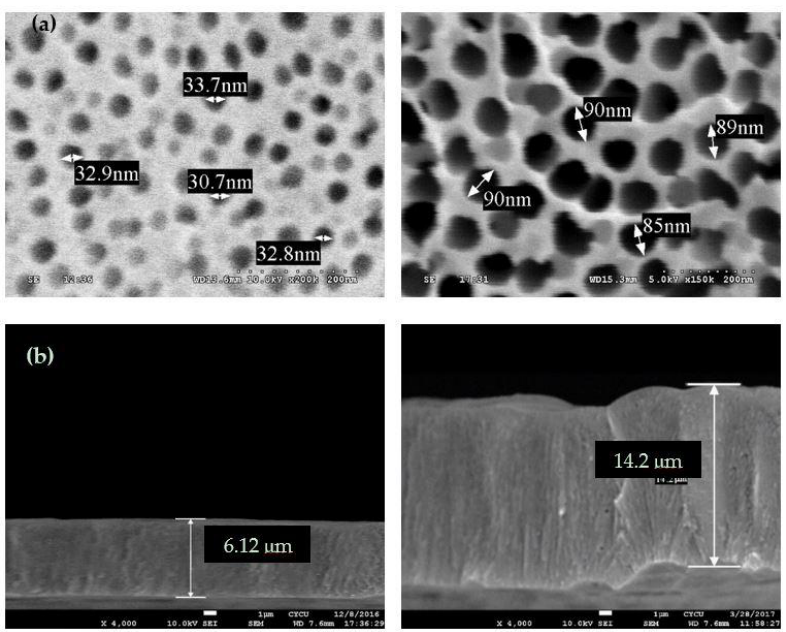
Figure 3. ( a ) AAO nanotube diameters obtained at anodizing voltages of 20 V and 50 V; and ( b ) AAO nanotube lengths obtained at treatment times of 3 h and 7 h.